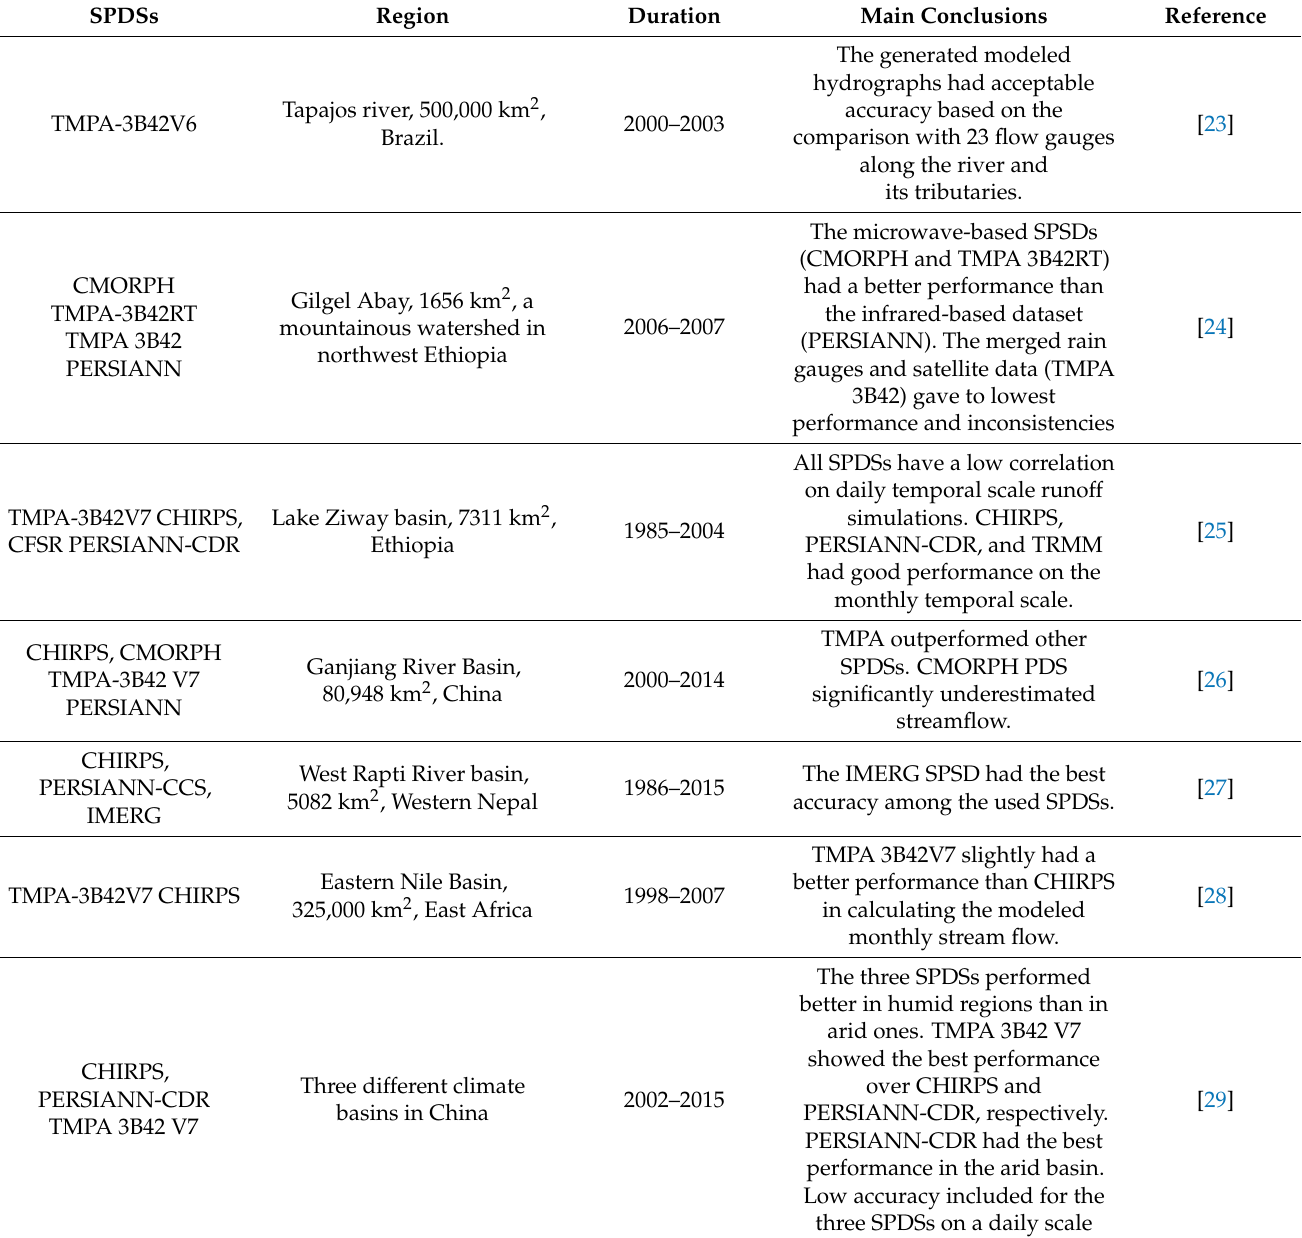
Table 2. Review of previous SPDSs hydrological modeling